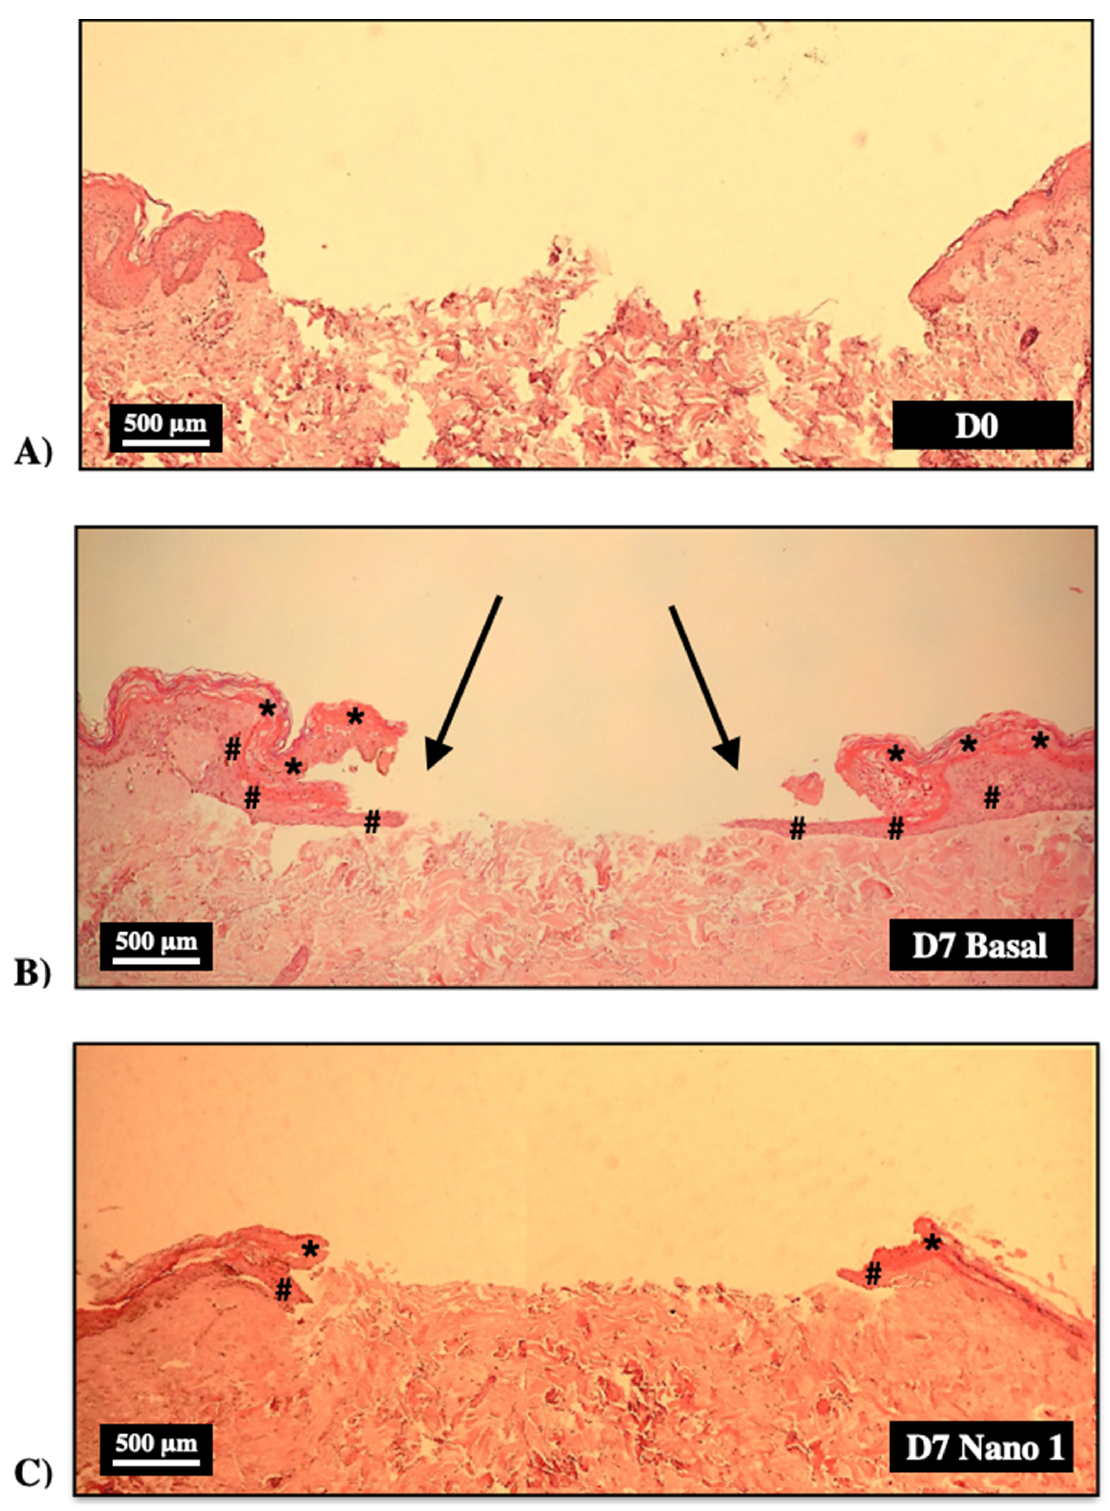
Figure 7. Histological sections of human skin fragments immediately (D0) after ulcer induction ( A ) and after 7 days (D7) kept in DMEM culture medium ( B ) and treated with daily application of Nano-1 without dilution (6.5 × 10 13 particles/mL) ( C ). Hematoxylin-eosin staining. 100 × magnification. Arrows show the lining of the ulcer by a new epithelium. * stratum corneum, # new epithelium.